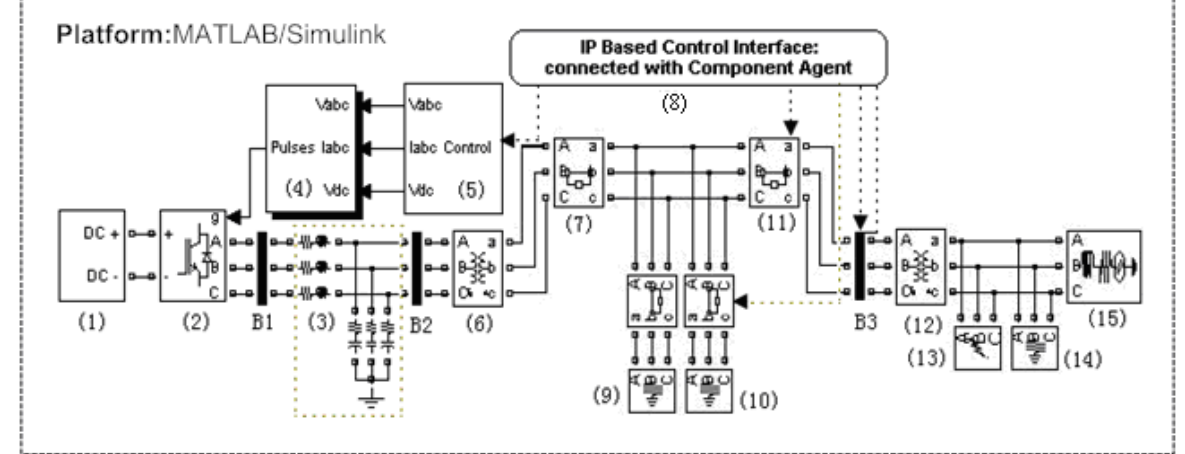
Figure 4. Microgrid simulation circuit based on MATLAB/Simulink